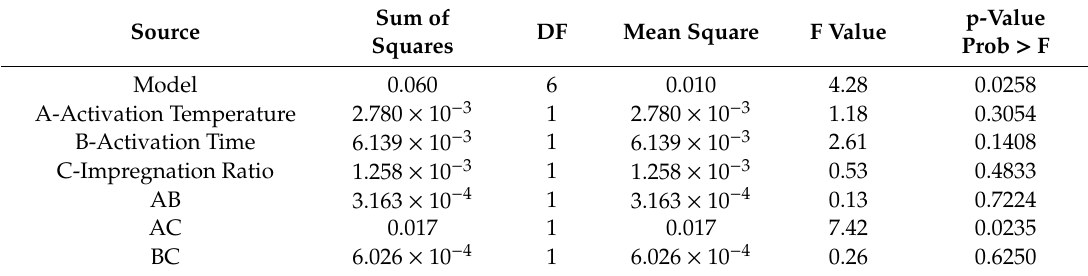
Table 5. Uptake capacity (mg · g − 1 ) surface modified